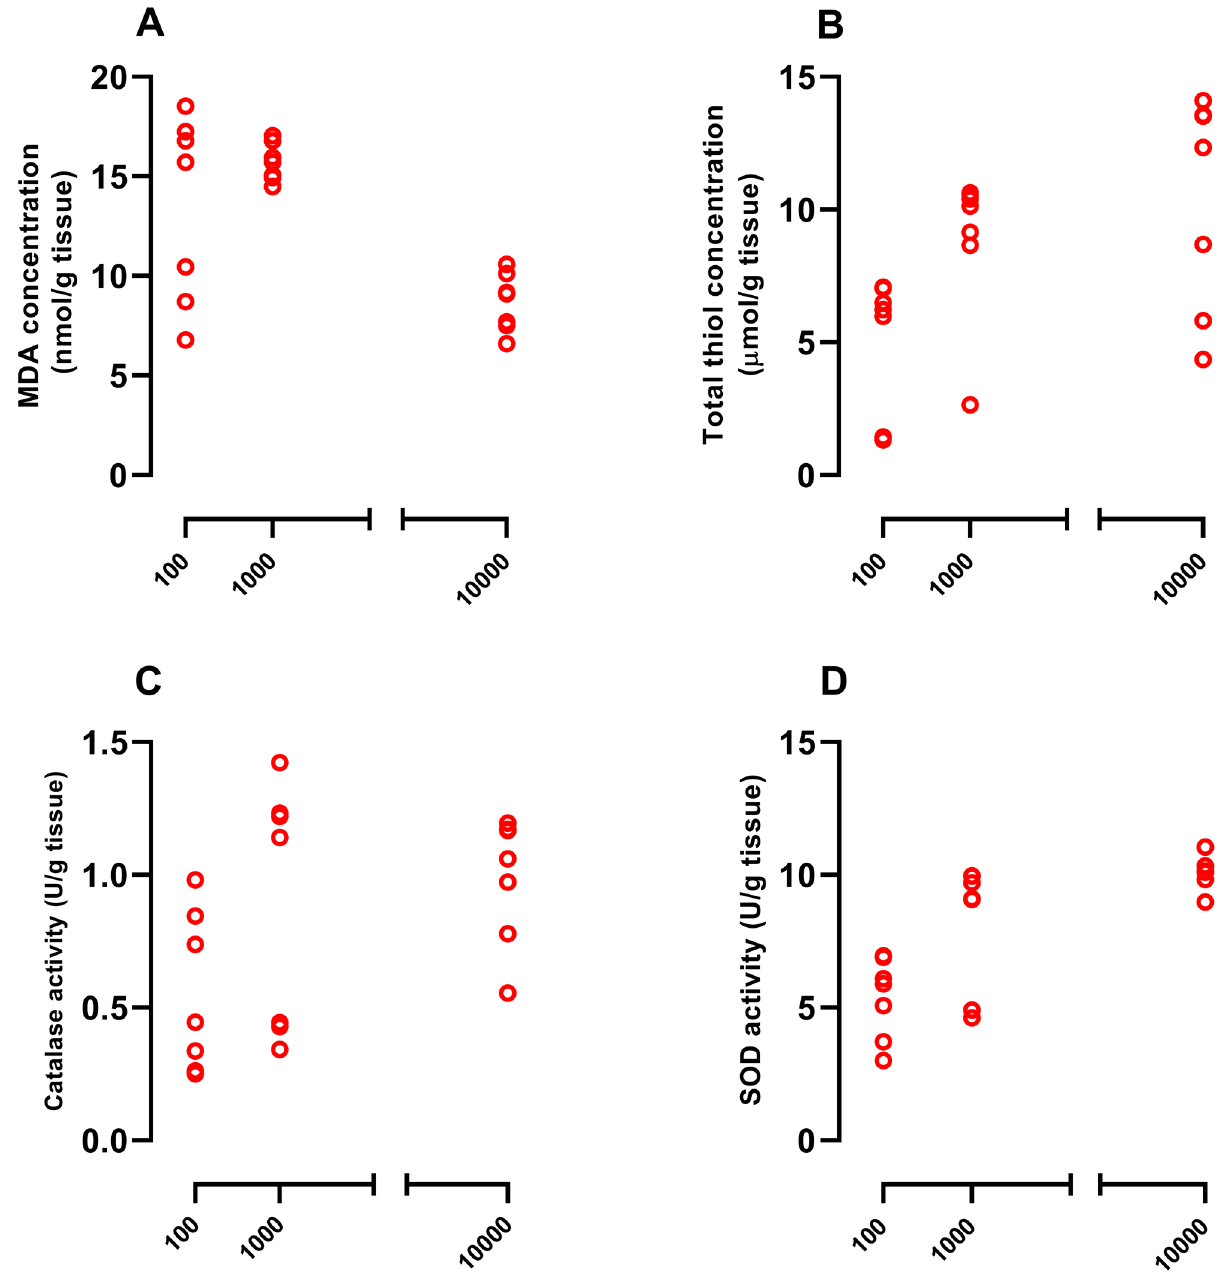
Figure 9. Correlation of Vit D doses with MDA ( A ), total thiol ( B ), catalase ( C ) and SOD ( D ). As indicated, there is a positive correlations between doses of Vit D and total thiol content and SOD activity (Pearson r = 0.4596, P < 0.05 and Pearson r = 0.6767, P < 0.001, respectively), however, this was found to be negative in case of MDA levels (Pearson r = − 0.6799, P < 0.001). No significant correlation was found for catalase activity (Pearson r = 0.3658 and P =